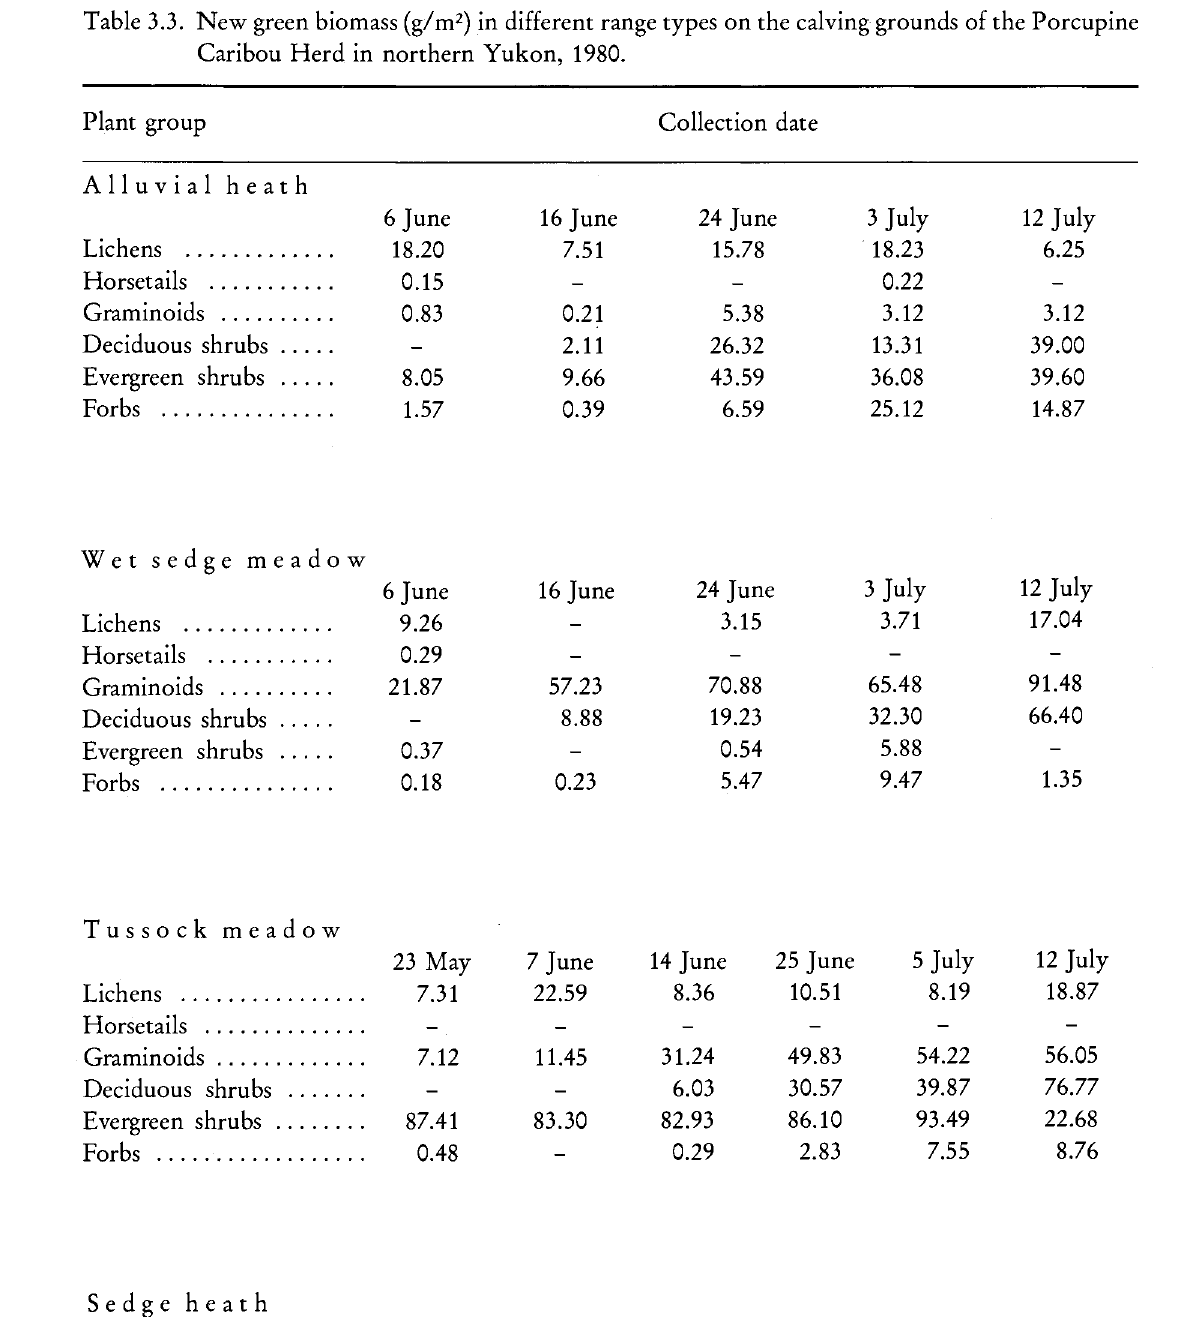
Table 3.3. N ew green biomass (g/m 2 ) in different range types on the calving grounds of the Porcupine Caribou Herd in northern Yukon,